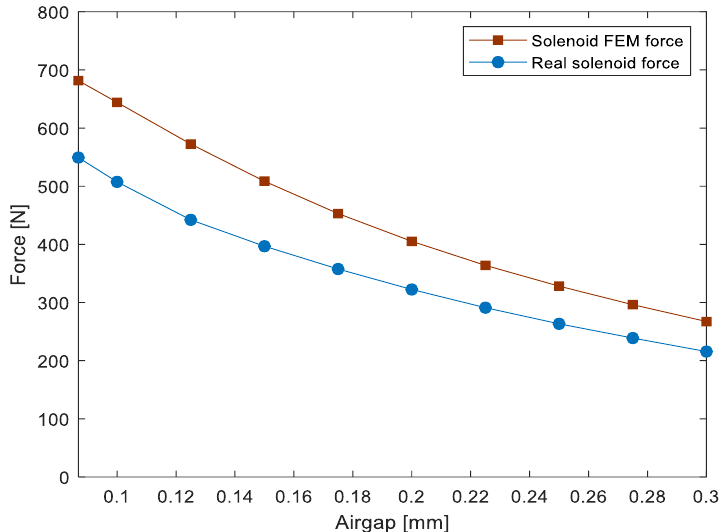
Figure 11. Comparison between numerical and experimental results about solenoid forces.